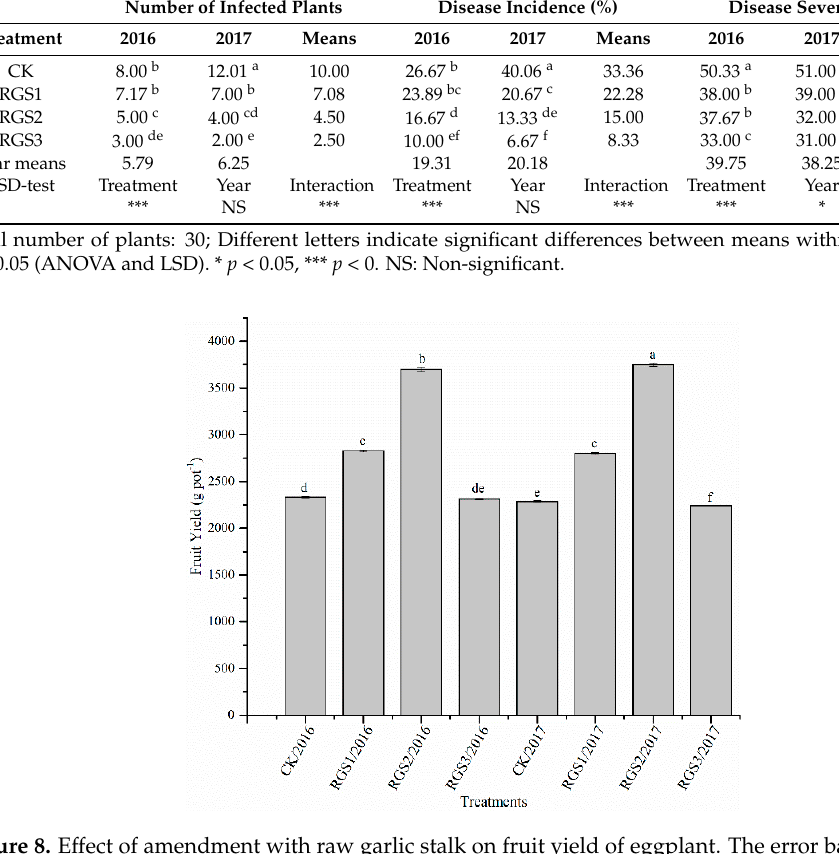
Figure 8. Effect of amendment with raw garlic stalk on fruit yield of eggplant. The error bars represent standard error of the means ( n = 3). Different letters indicate different means for each treatment two year combination significant difference at p < 0.05 level (ANOVA and LSD).